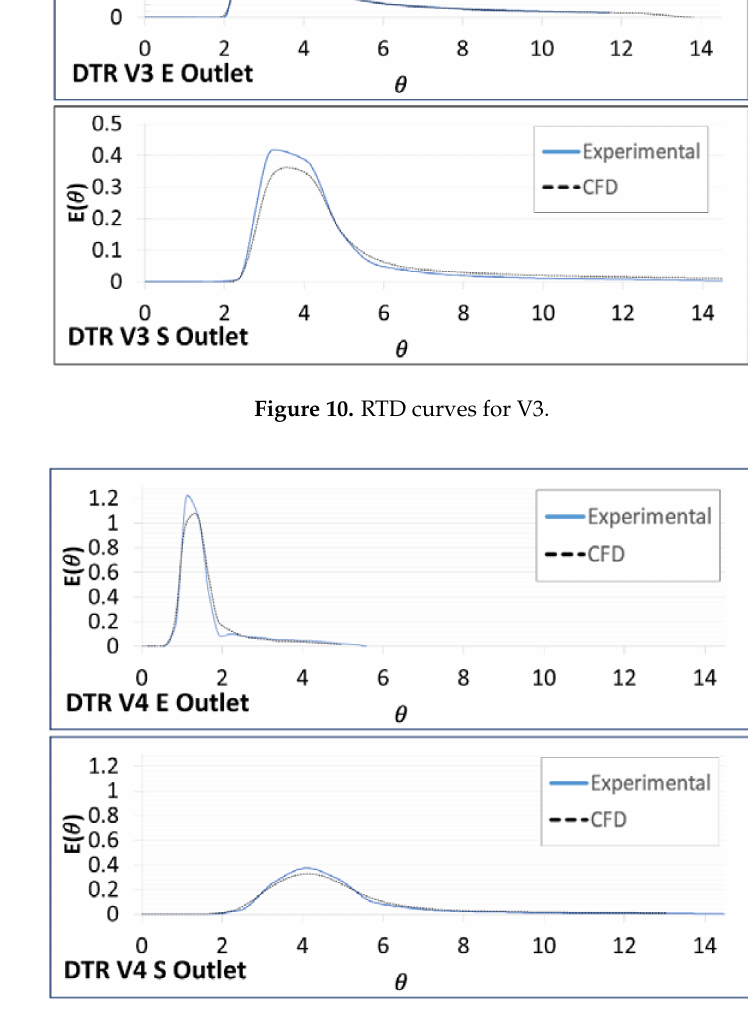
Figure 11. RTD curves for